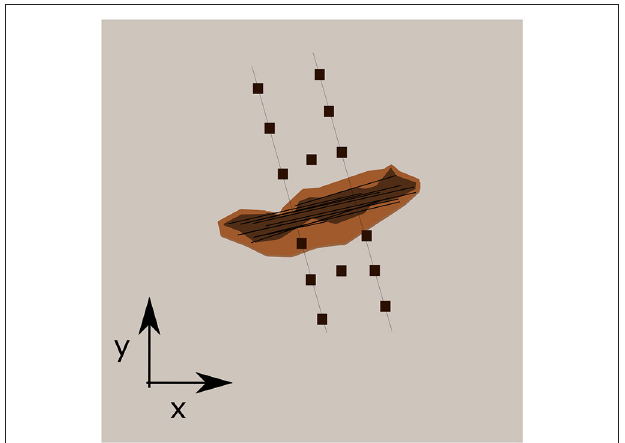
FIGURE 8 | Schematic picture illustrating sediment redeposition obtained from ROV and towed camera imagery. The sediments deposition thicknesses are qualitatively referred to as thick and thin coverage and are shown in dark brown and light brown, respectively. The layout of sensors is depicted in the background as black squares. The figure is not